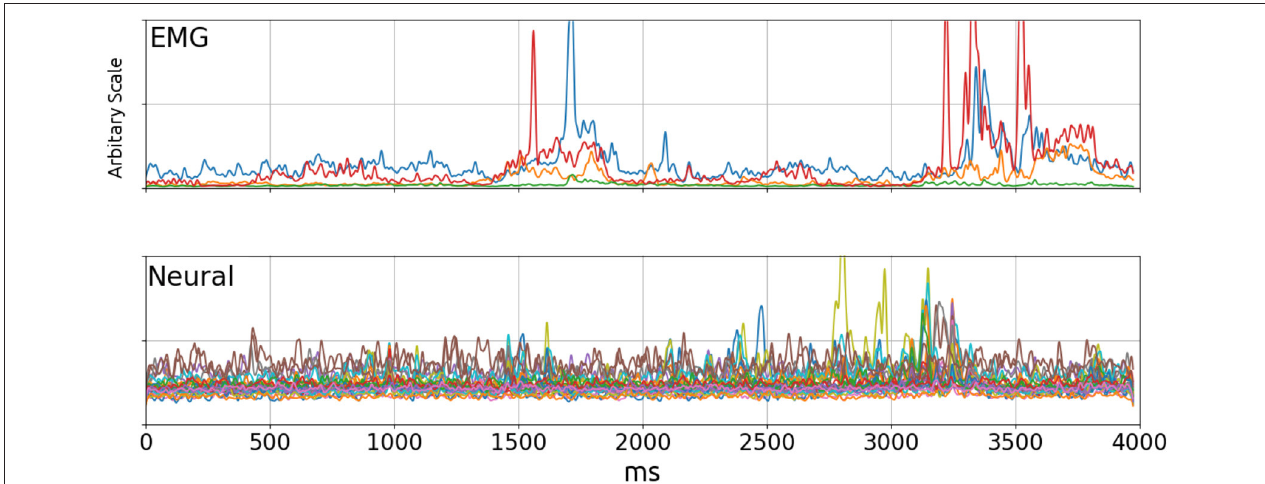
FIGURE 2 | EMG (Top) and Neural (Bottom) signal envelopes from a trial. By visual inspection, there did not appear to be a significant correlation between the two signals. The poor performance of linear decoders testifies to the lack of correlation. Top: Blue, Wrist flexor; Orange, Biceps; Green, Triceps; Red, Wrist Extensor.